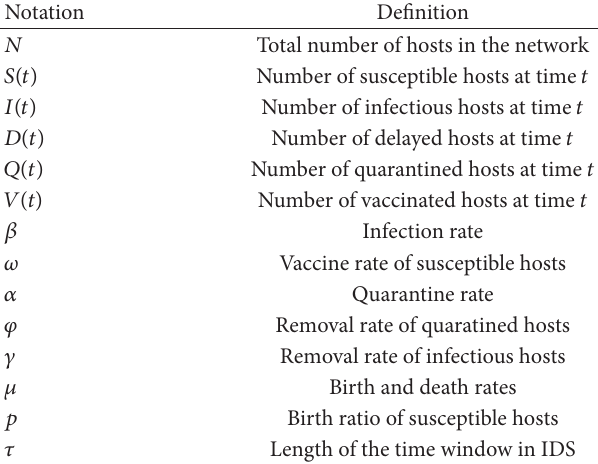
Figure 3: State transition diagram of the delayed model.